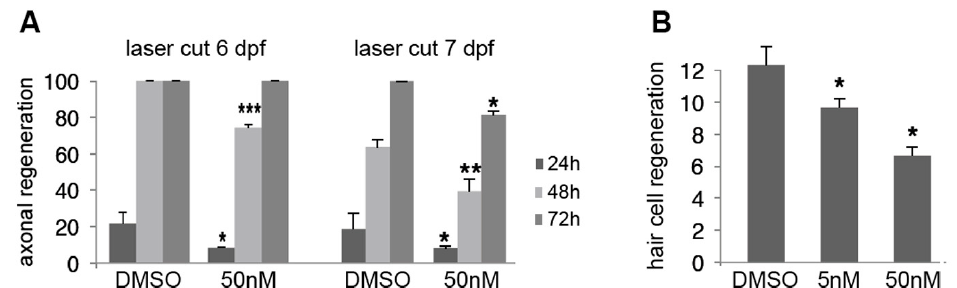
Figure 6. Effect of A6 on axonal and hair cell regeneration. ( A ) Extent of axonal regeneration expressed as % of neuromasts that had been reinnervated after the nerve was cut just posterior to L1 at 6 dpf or 7 dpf. Larvae were exposed to A6 between 1 and 5 dpf ( left panel ) and between 1 and 6 dpf ( right panel ), and reinnervation was examined 1, 2 and 3 days after the cut; ( B ) Extent of hair cell regeneration expressed as number of hair cells present 1 day after complete ablation of all hair cells through copper sulfate treatment at 7 dpf. Larvae had been exposed to A6 between 1 and 6 dpf. Three independent experiments were performed for laser cut, n = 18 larvae for each condition, and three independent experiments were performed for regeneration experiment. Results are given as mean values ± standard error of mean (SEM). Data analysis: see Materials and Methods, Section 4.10. Symbols: * p < 0.05, ** p < 0.01; *** p < 0.001.